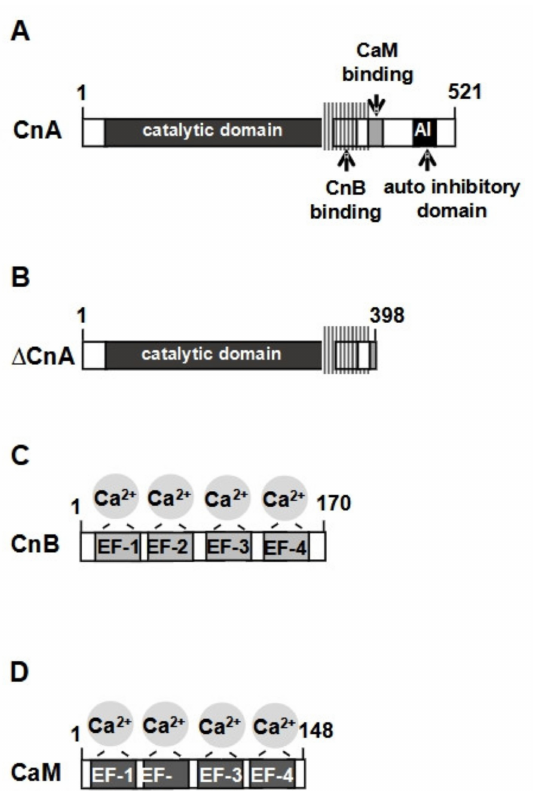
Figure 5. Modular structure of calcineurin. ( A ) Domain structure of calcineurin A. The enzyme has an extended catalytic domain, binding sites for calcineurin B and calmodulin and a C -terminal autoinhibitory domain that keeps the holoenzyme in an inactive state in the absence of elevated Ca 2+ concentrations. ( B ) The truncated calcineurin A mutant ( ∆ CnA) lacks the autoinhibitory domain and a portion of the calmodulin binding site. ( C , D ) Calcineurin B ( C ) and calmodulin ( D ) are small proteins containing 4 EF hands for Ca 2+